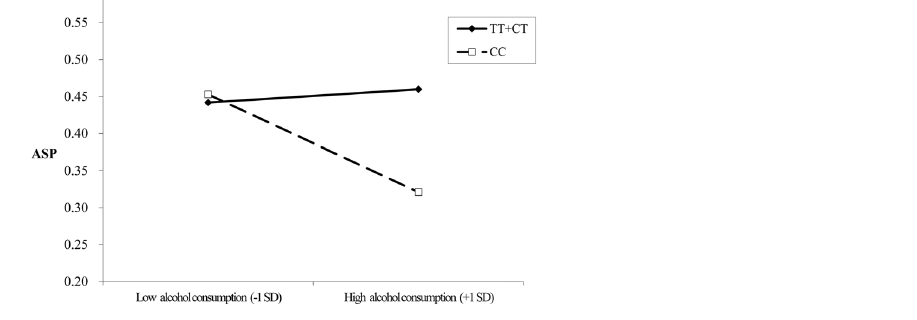
Figure 2. Relationship between rs4746720 and alcohol consumption, and ASP